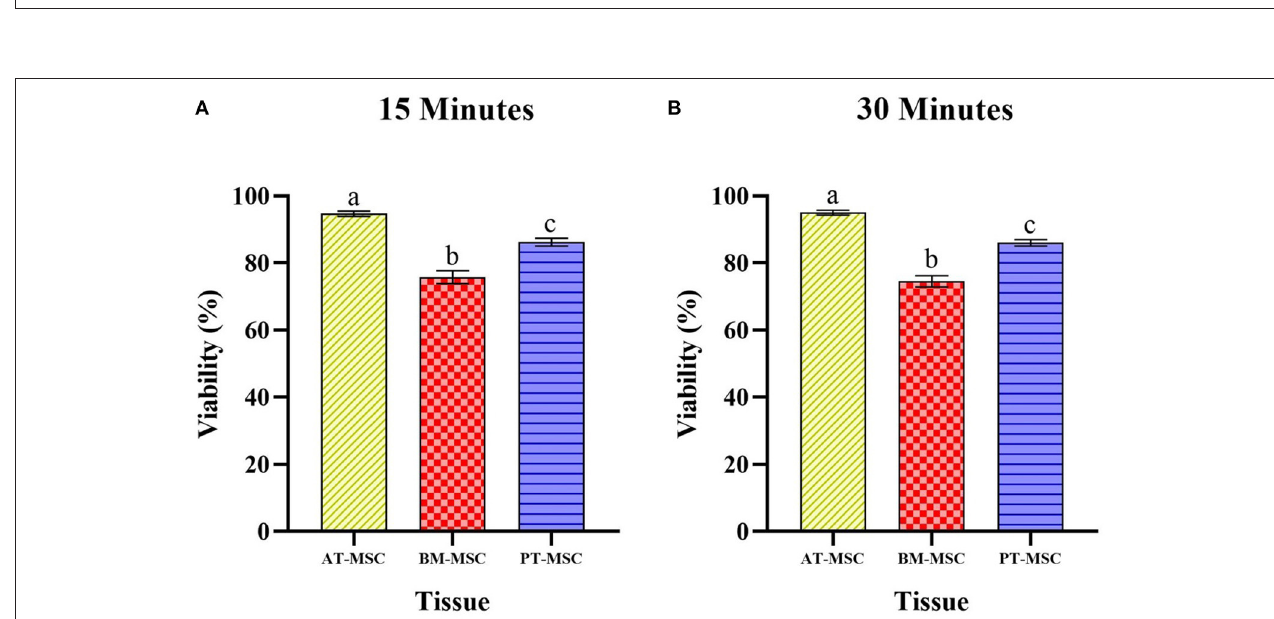
FIGURE 5 | Average viability (%) ± SEM presented by bovine fetal adipose tissue (AT-MSC), bone marrow (BM-MSC), and placenta (PT-MSC) mesenchymal stem cells after being exposed to the experimental treatments for 15min (A) and 30min (B) . (a–c) Different letters indicate significant statistical differences ( P < 0.001) between the tissue sources